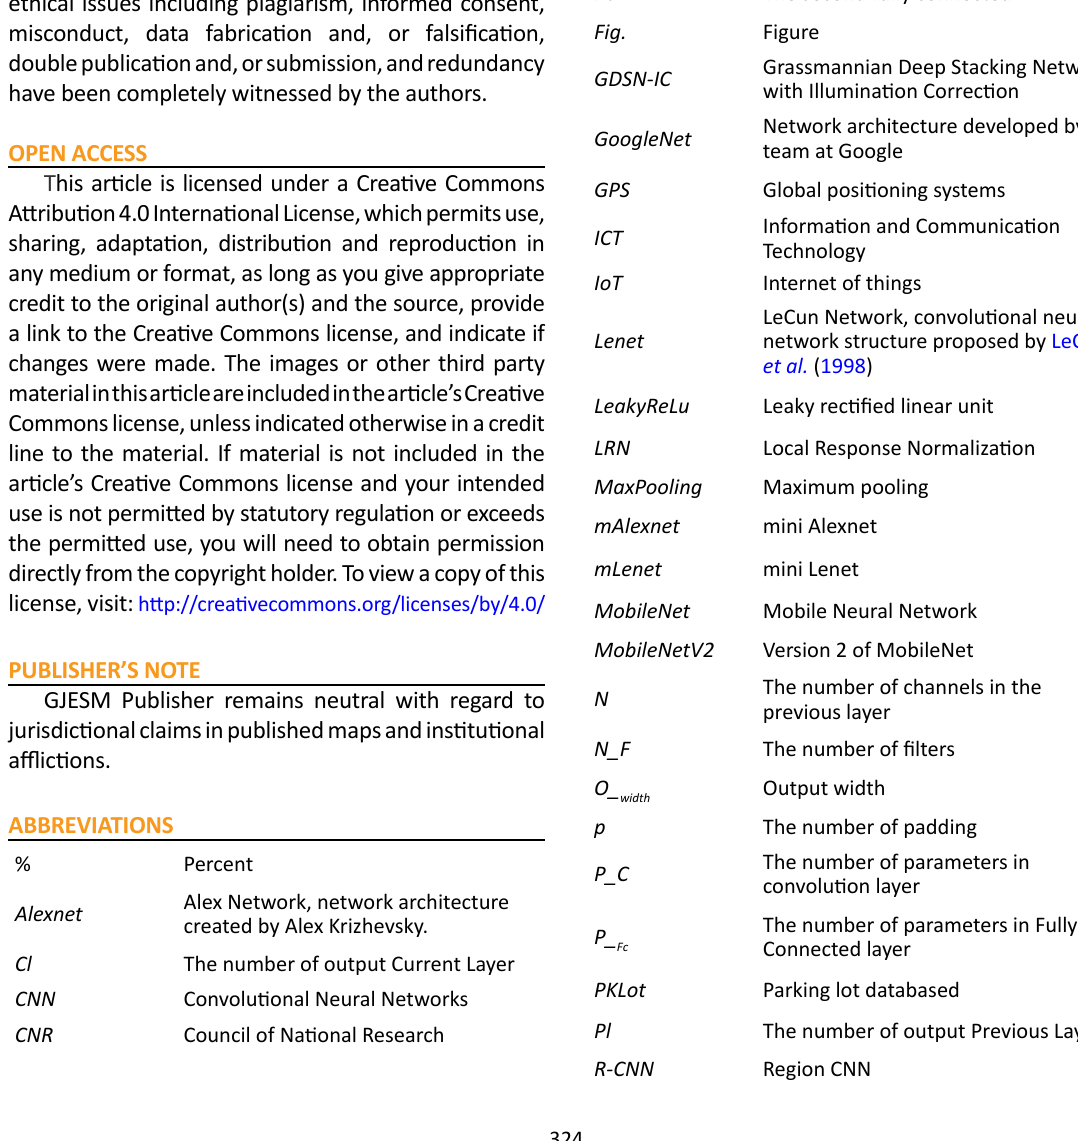
Figure Grassmannian Deep Stacking Network GDSN-IC with Illumination Correction Network architecture developed by a GoogleNet team at Google